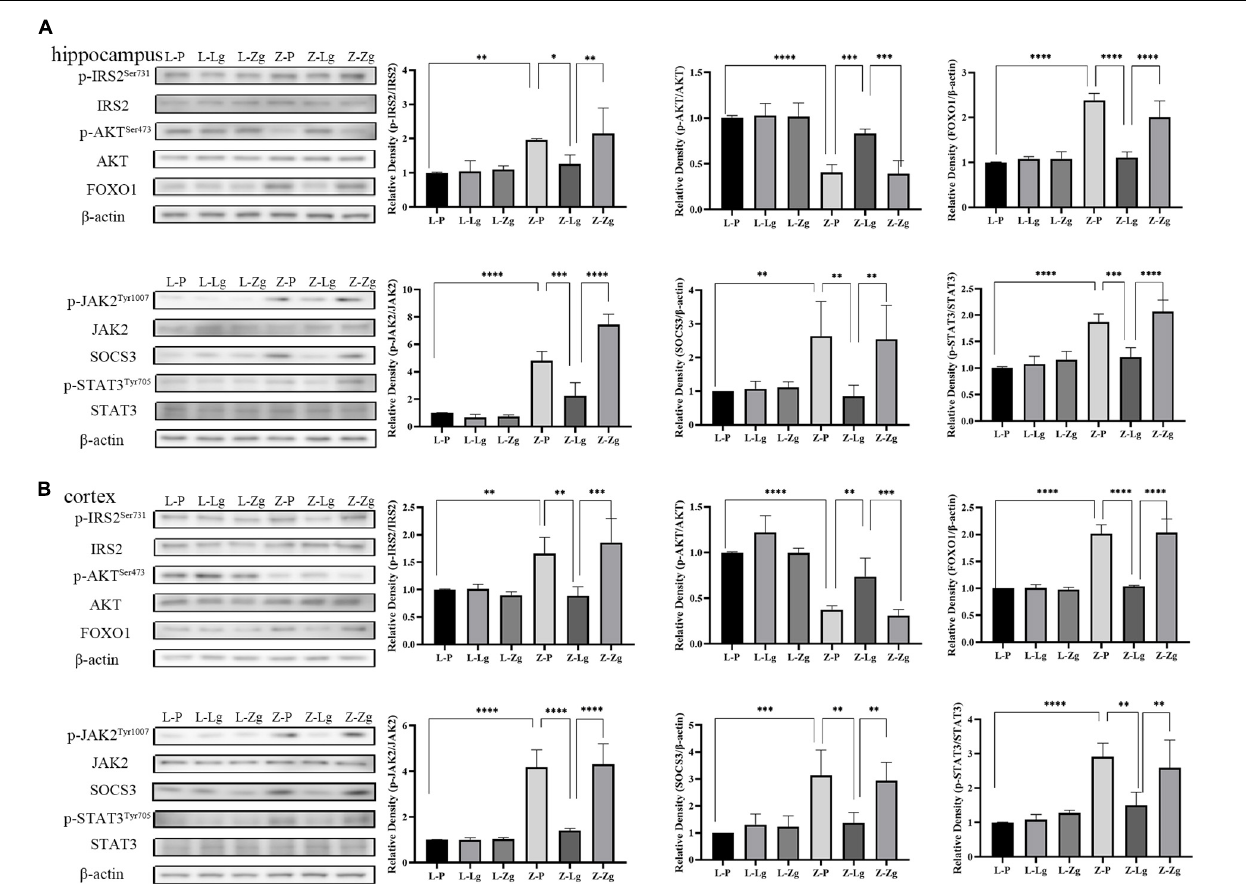
FIGURE 4 | GMT changes leptin/insulin resistance in ZDF recipient rats. (A) Western blotting analysis of components of the insulin and leptin signaling pathway in the hippocampus regions [p-IRS2: F ( 5 , 12 ) = 6.281, P = 0.0044; p-AKT: F ( 5 , 12 ) = 23.24, P < 0.0001; FOXO1: F ( 5 , 12 ) = 33.04, P < 0.0001; p-JAK2: F ( 5 , 12 ) = 68.28, P < 0.0001; SOCS3: F ( 5 , 12 ) = 5.399, P = 0.0079; p-STAT3: F ( 5 , 12 ) = 24.59, P < 0.0001]. (B) Western blotting analysis of components of the insulin and leptin signaling pathway in the cortex regions [p-IRS2: F ( 5 , 12 ) = 10.19, P = 0.0005; p-AKT: F ( 5 , 12 ) = 28.83, P < 0.0001; FOXO1: F ( 5 , 12 ) = 52.65, P < 0.0001; p-JAK2: F ( 5 , 12 ) = 33.76, P < 0.0001; SOCS3: F ( 5 , 12 ) = 8.807, P = 0.0010; p-STAT3: F ( 5 , 12 ) = 12.40, P = 0.0002]. Data are shown as mean ± SD ( n = 3 per group). ∗ P < 0.05, ∗∗ P < 0.01, ∗∗∗ P < 0.001, ∗∗∗∗ P < 0.0001. One-way or two-way ANOVA, followed by Tukey’s post-hoc